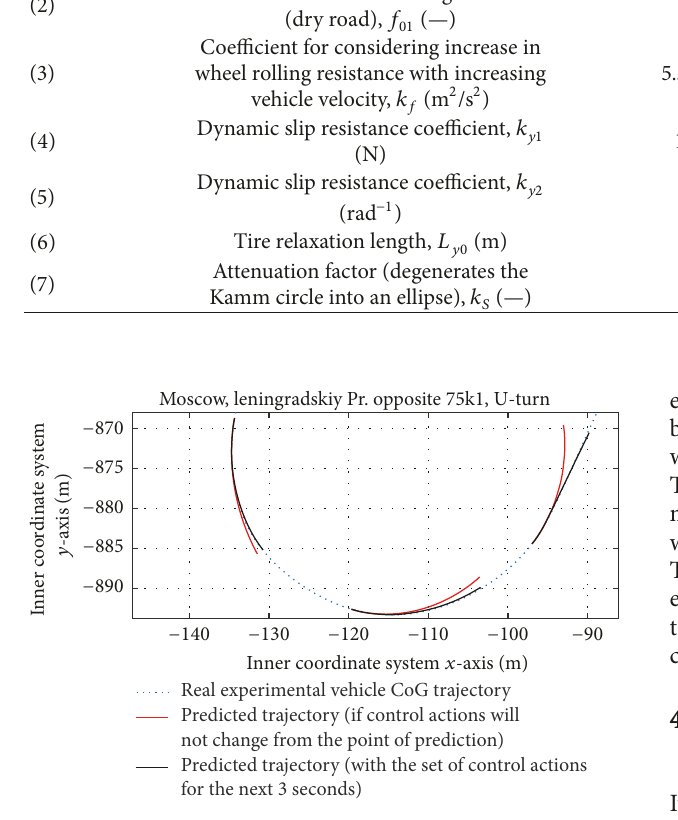
Figure 5: Trajectories of the experimental autonomous vehicle.